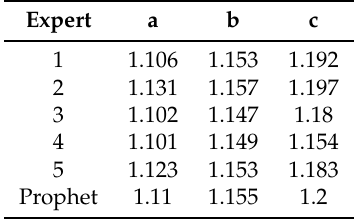
Table 3. Round 2 of the fuzzy Delphi